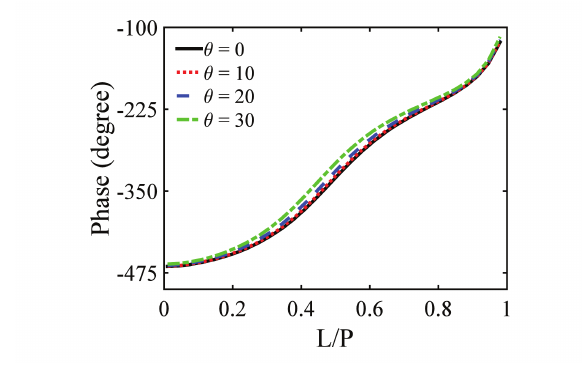
Figure 4: Reflection phase of the unit cell at 10 GHz for different values of incidence